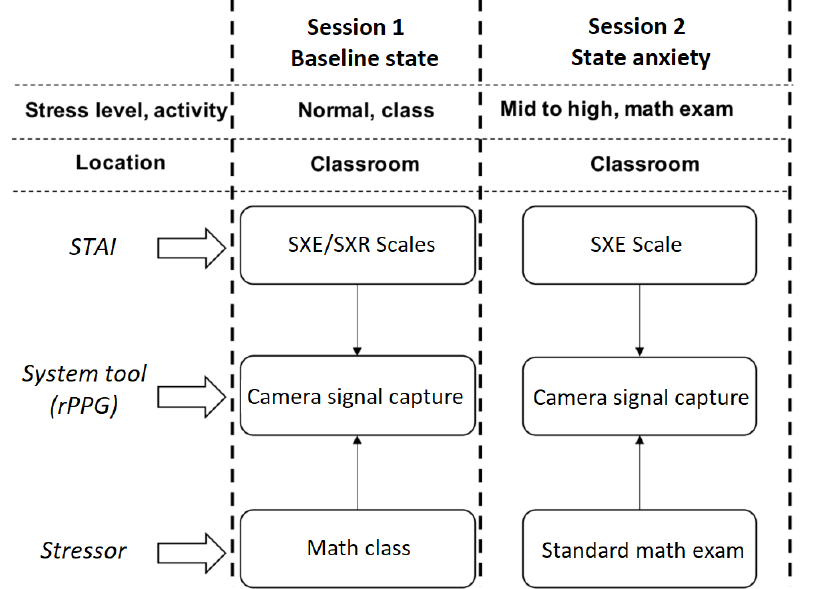
Figure 4. The academic stress protocol was designed to detect and assess anxiety during a class and measure changes during a written